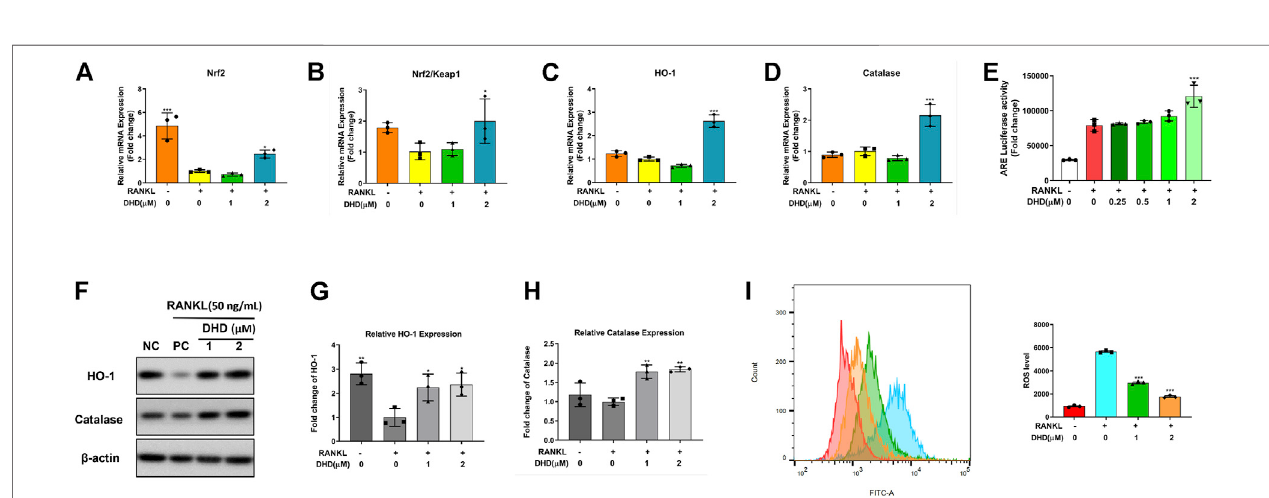
FIGURE 9 | DHD increases the expression of ROS scavenging genes and proteins and ARE activity. (A – D) Relative mRNA expression of Nrf2, Nrf2/Keap1, Ho-1, and CAT. (E) DHD slightly improves the ARE luciferase activity of RAW 264.7 cells stably transfected with the ARE luciferase construct. (F) Representative Western blottingimages ofHO-1 and catalase. (G,H) Theratios ofbandintensityoftheaboveproteins,whichwererelative to β -actin expression, were quantitatively analyzed. (I) BMMs were treated with 50 ng/ml RANKL and DHD at different concentrations (0, 1, and 2 μ M), and fl ow cytometric analysis was conducted to quantify ROS production (mean fl uorescence